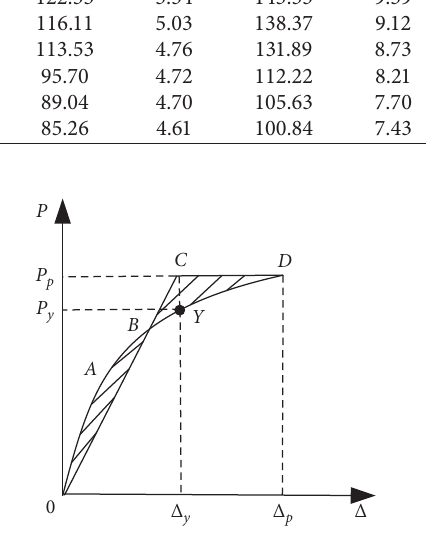
Figure 9: Definition of the yielding